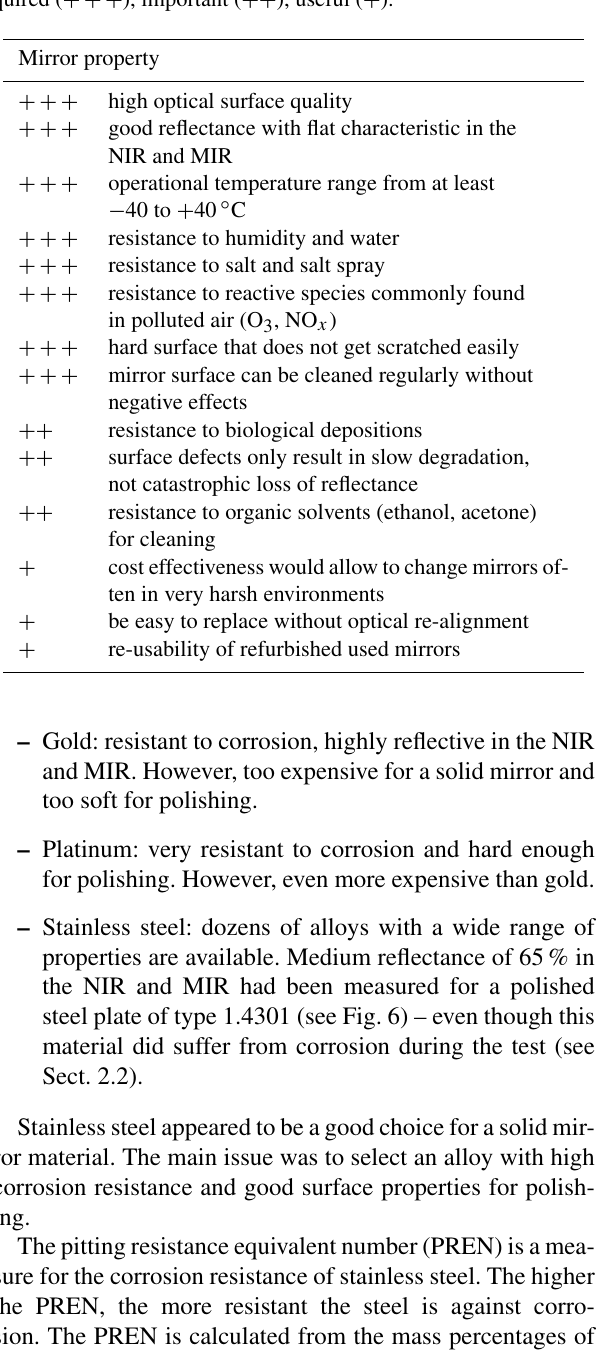
Table 2. Design properties for rugged mirrors. The first column provides a measure of importance for the individual properties: re- quired ( +++ ), important ( ++ ), useful ( + ).